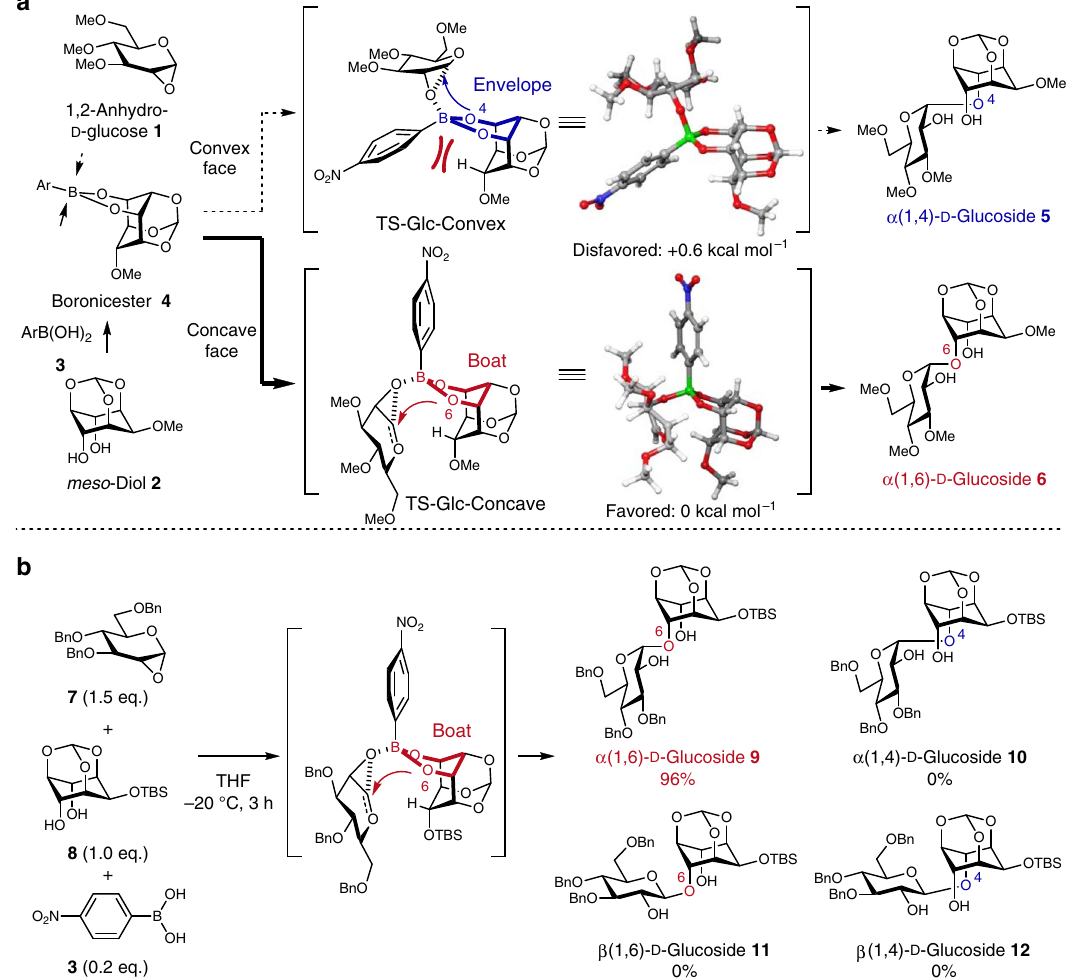
Fig. 2 Desymmetric glycosylation using 1,2-anhydro-d-glucose. a Transition states calculated using B3LYP/6-31G* (single point energy: B3LYP/ 6-31 + G**). b Desymmetric glycosylation of 7 and 8 . TS transition state, Me methyl, Bn benzyl, THF tetrahydrofuran, TBS tert